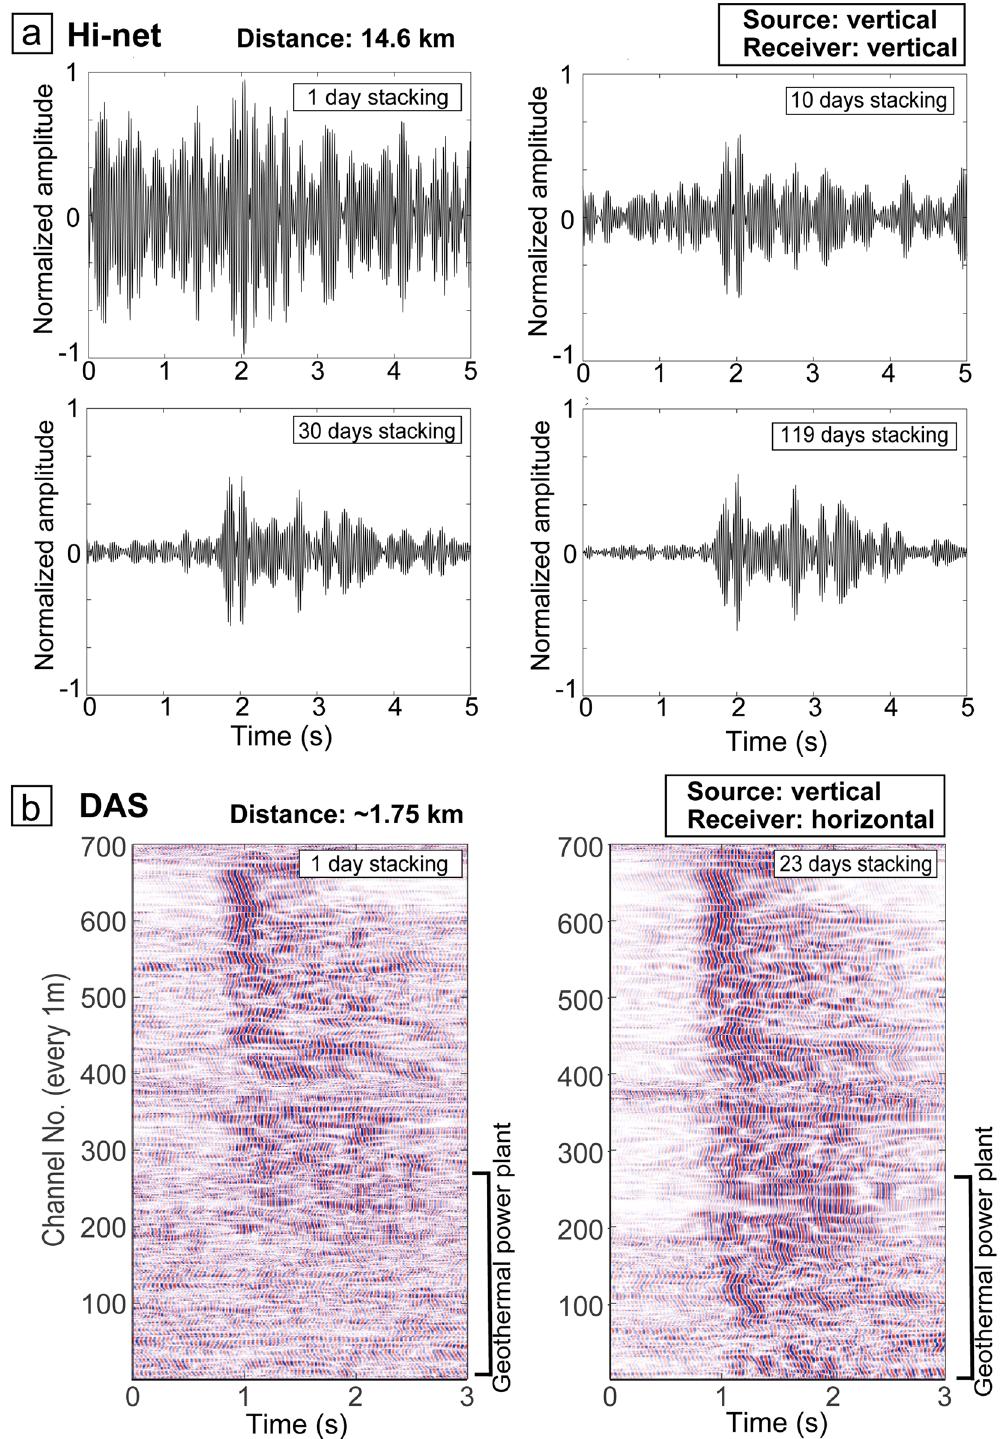
Figure 3. Improvement of signal-to-noise ratio of the monitoring signals by stacking. ( a ) Transfer functions between the source and a Hi-net seismometer for different numbers of stacking days, derived from vertical source motions and the vertical receiver component. The Hi-net seismometer is 14.6 km from the source system (X in Fig. 2a). ( b ) Transfer functions between the source and the 700 channels of the DAS system derived from vertical force data. The high-amplitude waveforms at ~ 1 s represent signals from the continuous monitoring system. The fiber-optic cable is 1.75 km from the source system (green line in Fig.